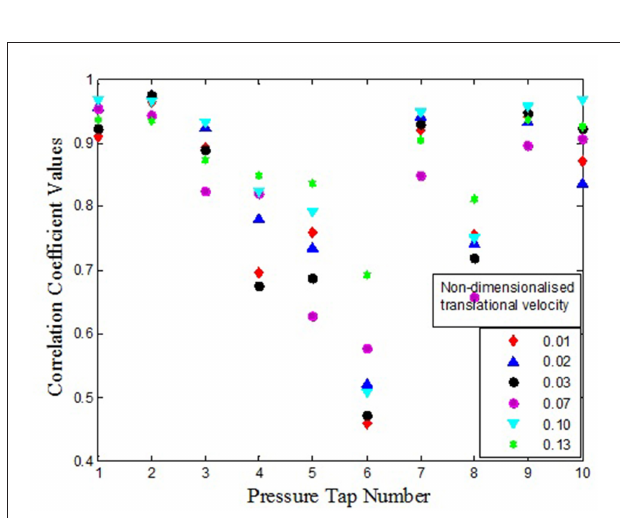
FIGURE 14 | Correlation coefficient values for opening on windward wall.